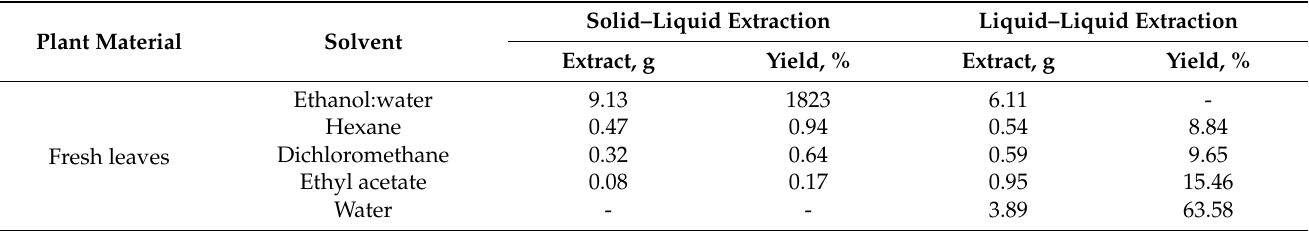
Table 5. Ultrasound-assisted exhaustive extraction with different solvents of fresh leaves of Steiractinia aspera